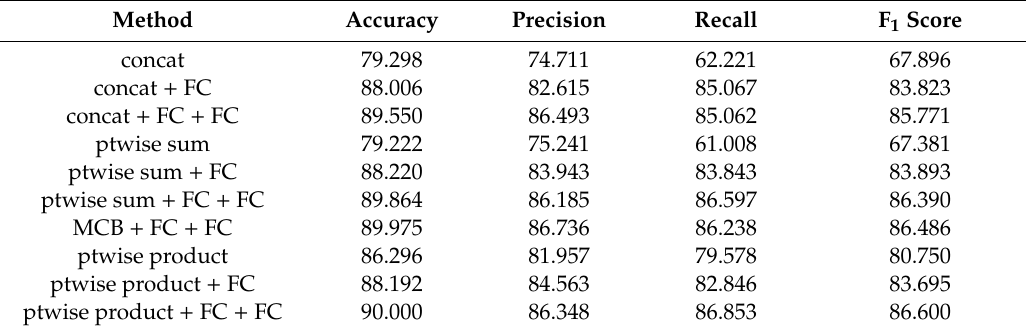
Table 9. Performance analysis for di ff erent combinations of the image feature and query feature in the proposed